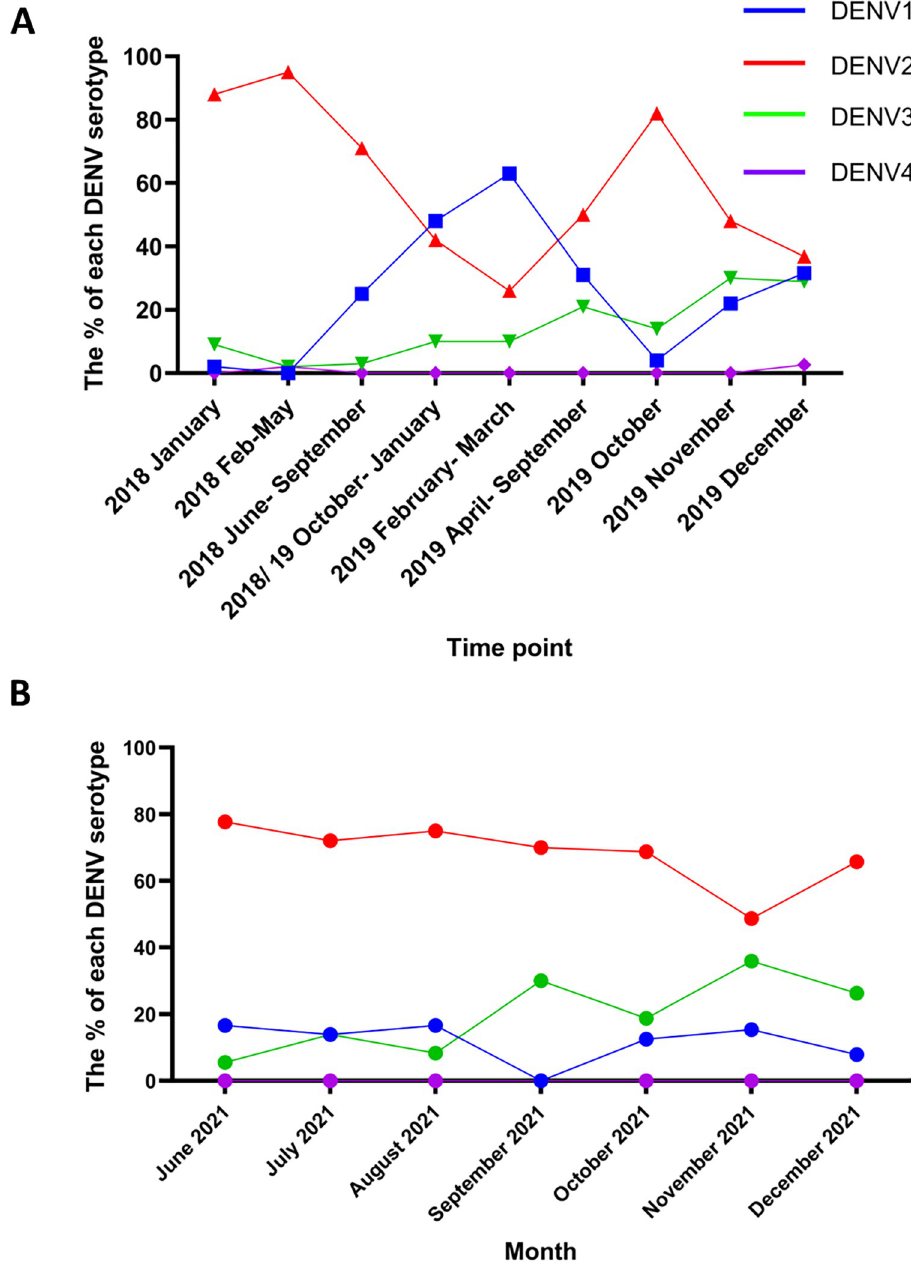
Fig 2. Changes in the circulating dengue virus serotypes in Colombo from 2018 to 2021. Serotyping of the DENVs was carried out on sera obtained from patients with acute dengue, in the Colombo district from 2018 to end of 2019 (A) and from June 2021 to December 2021(B). The percentage of each DENV serotype is